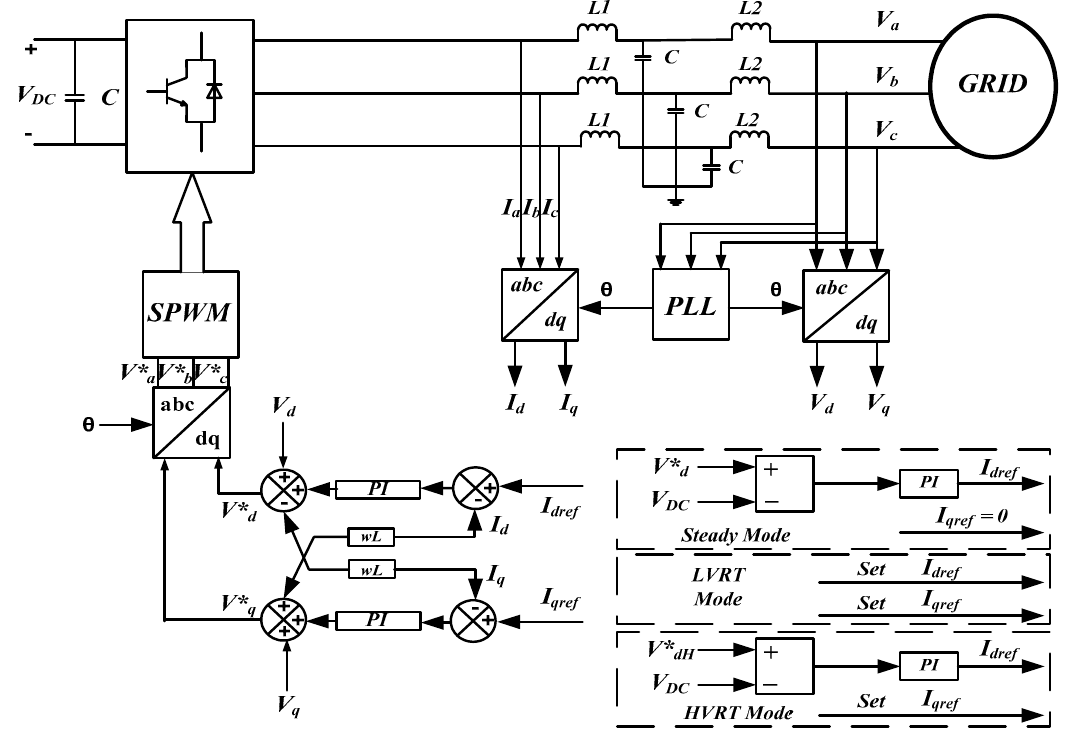
Figure 21. Control diagram of the LVRT and HVRT [38].